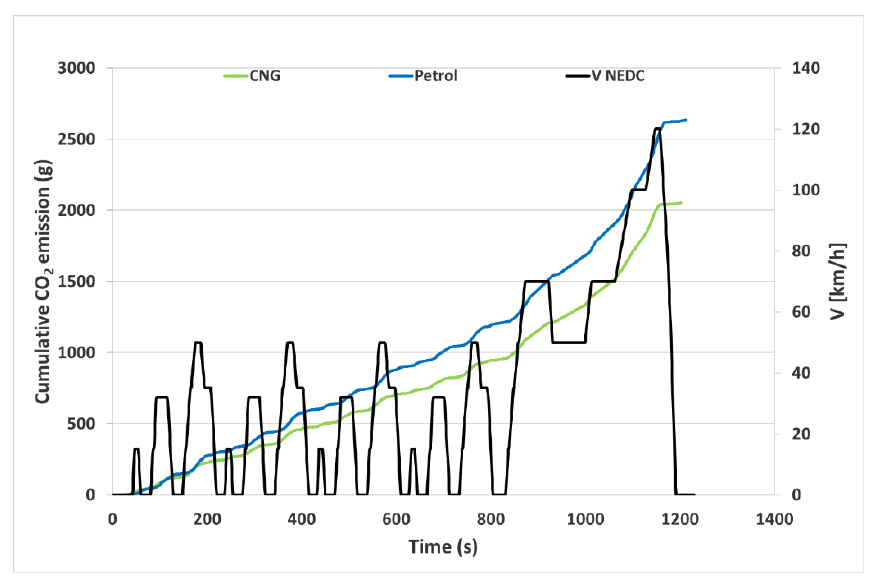
Figure 7. Cumulative CO 2 emission of a vehicle fueled with petrol and CNG for the NEDC test.